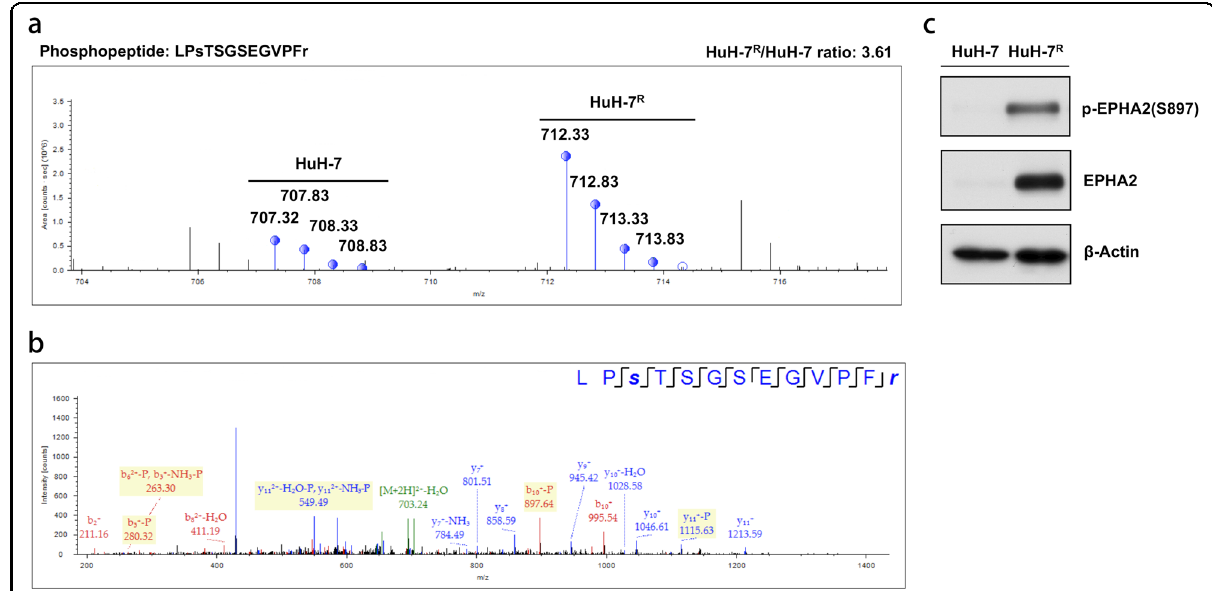
Fig. 2 The potential novel RTK candidate EphA2 for the modulation of drug resistance identi fi ed via quantitative MS. a The quanti fi ed MS spectra of the identi fi ed SILAC-labeled phosphopeptide of EphA2 are shown. b MS/MS spectra of the corresponding identi fi ed phosphopeptide of EphA2. c Validation of the change in the identi fi ed phosphorylation site of EphA2 between HuH-7 and HuH-7 R cells via western blotting. The identi fi ed peptide sequence, phosphorylated residue, and quanti fi ed ratio are presented. EPHA2 ephrin type A receptor